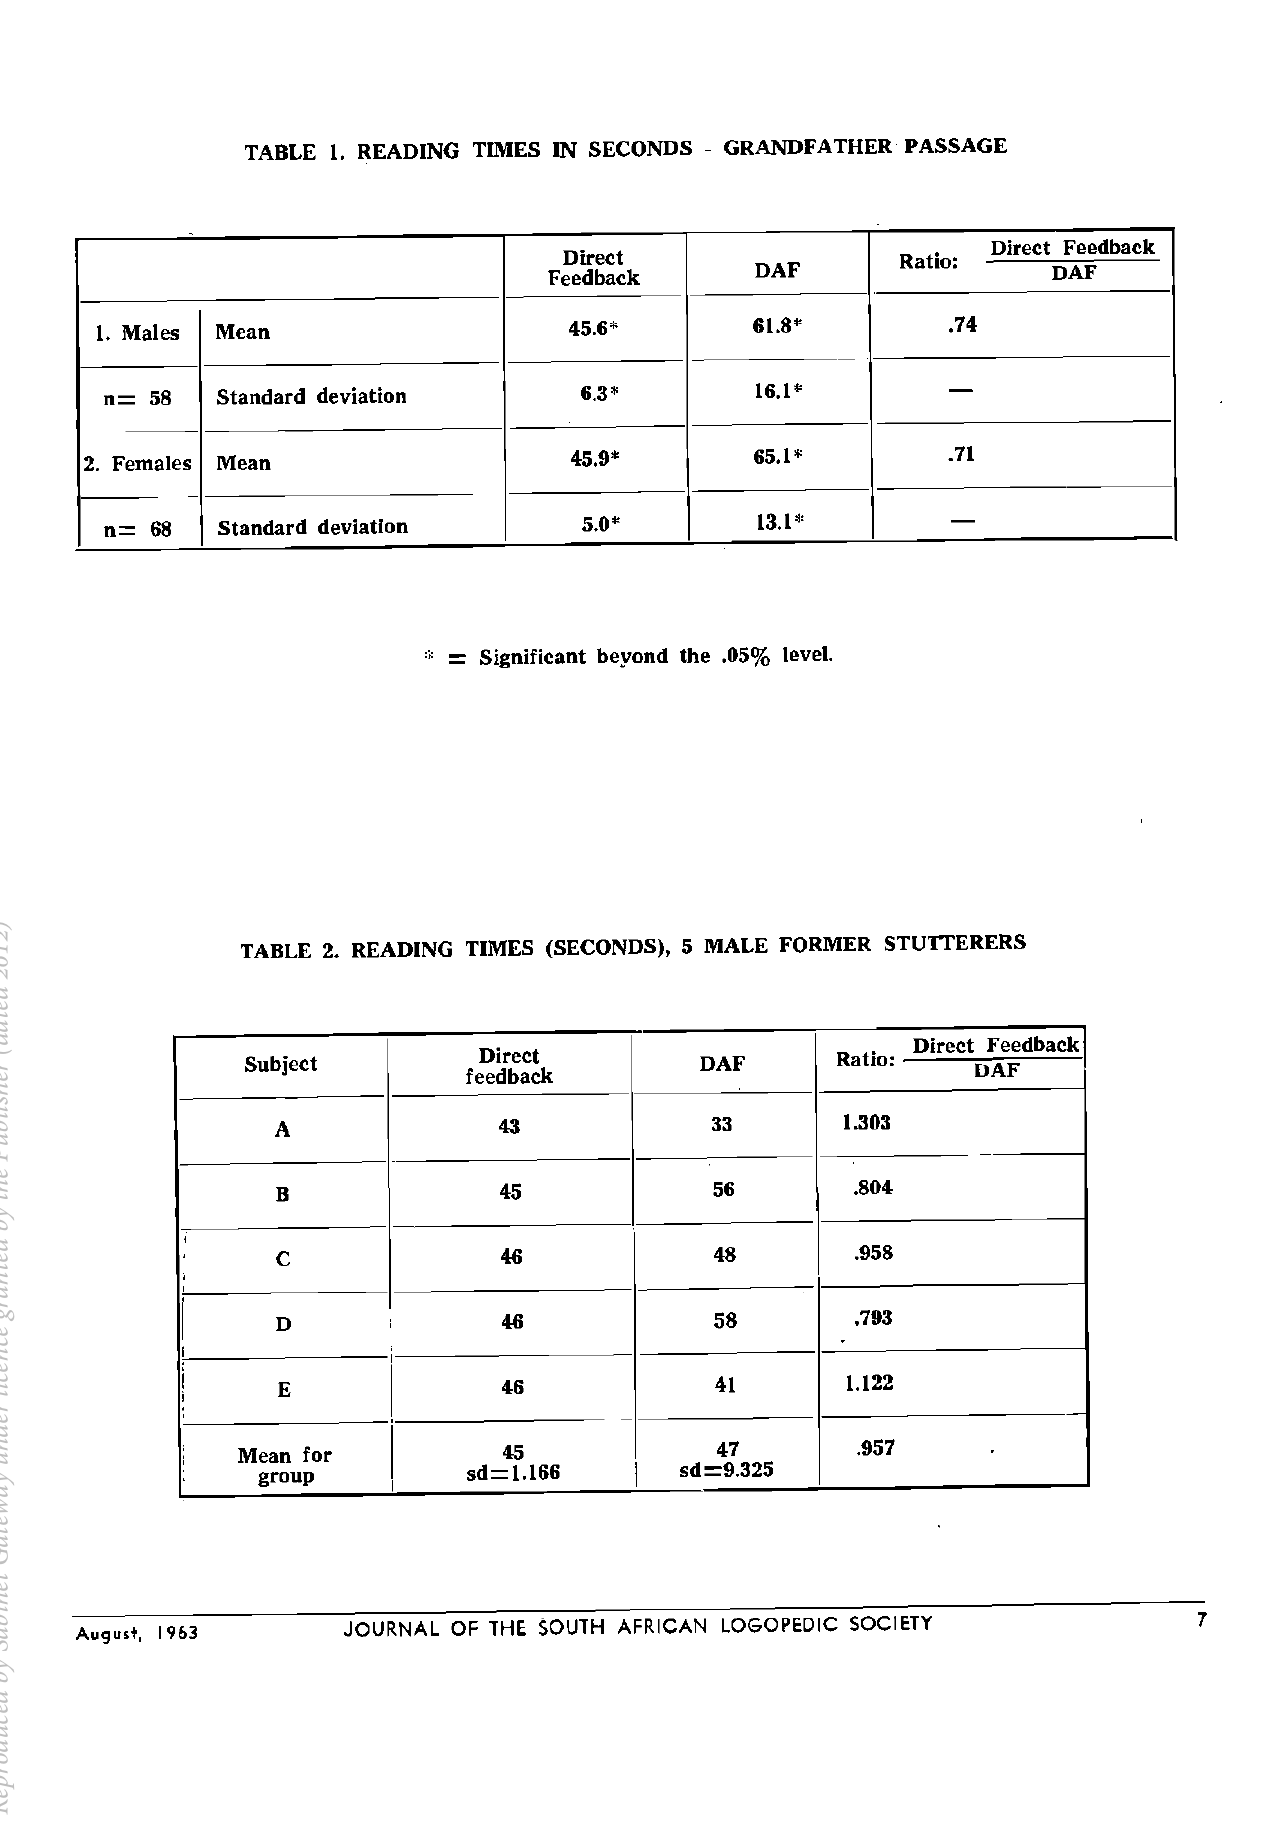
TABLE 2. READING TIMES (SECONDS), 5 MALE FORMER